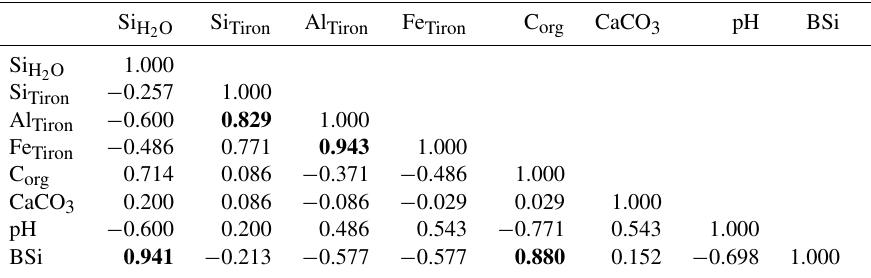
Table 3. Spearman’s rank correlations between measured soil parameters and total BSi (upper 5cm, n = 6) at Chicken Creek. Si H Si Tiron Al 2 O